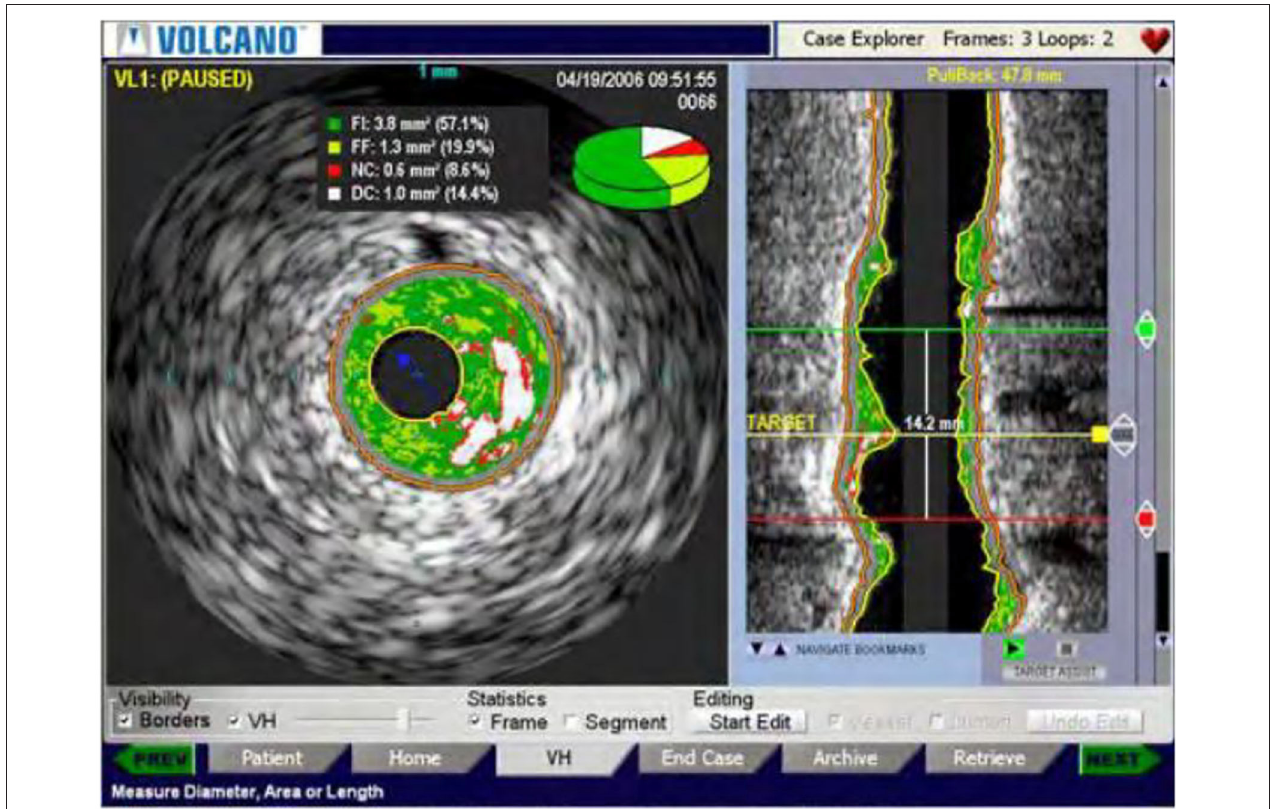
FIGURE 7 | VH-IVUS image of a new type of intravascular ultrasound.